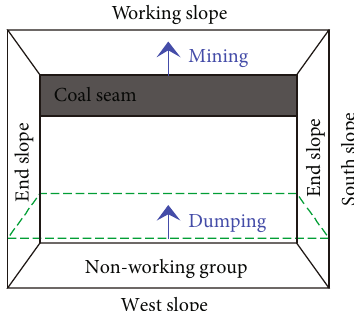
Figure 1: Sketch map for stope advance schematic.